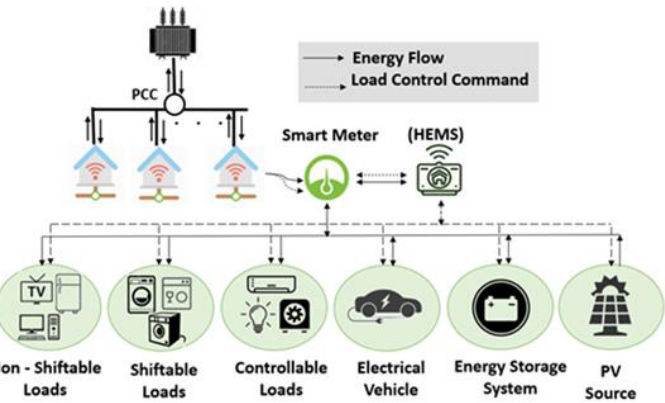
Figure 1. The proposed home energy management system (HEMS) demand response (DR) model and its considerations.